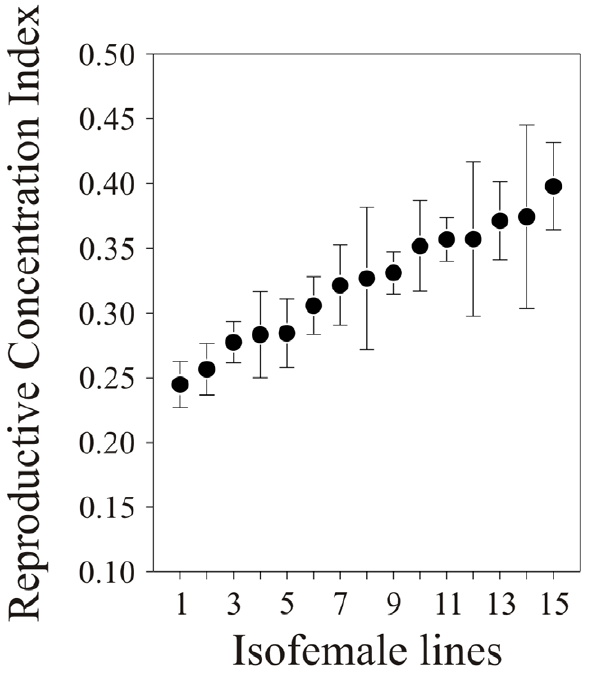
Figure 3. Average ( 6 SE) Reproductive Concentration Index (RCI) quantified for 15 isofemale lines of T . brassicae females. Lines are ordered according to increasing average values of the trait studied. Sample sizes for the 15 lines, from left to right, are: 4, 4, 3, 2, 4, 2, 2, 2, 3, 3, 5, 3, 5, 3 and 3. The inter-line variation is statistically significant (ANOVA: F 14,33 =2.08, P